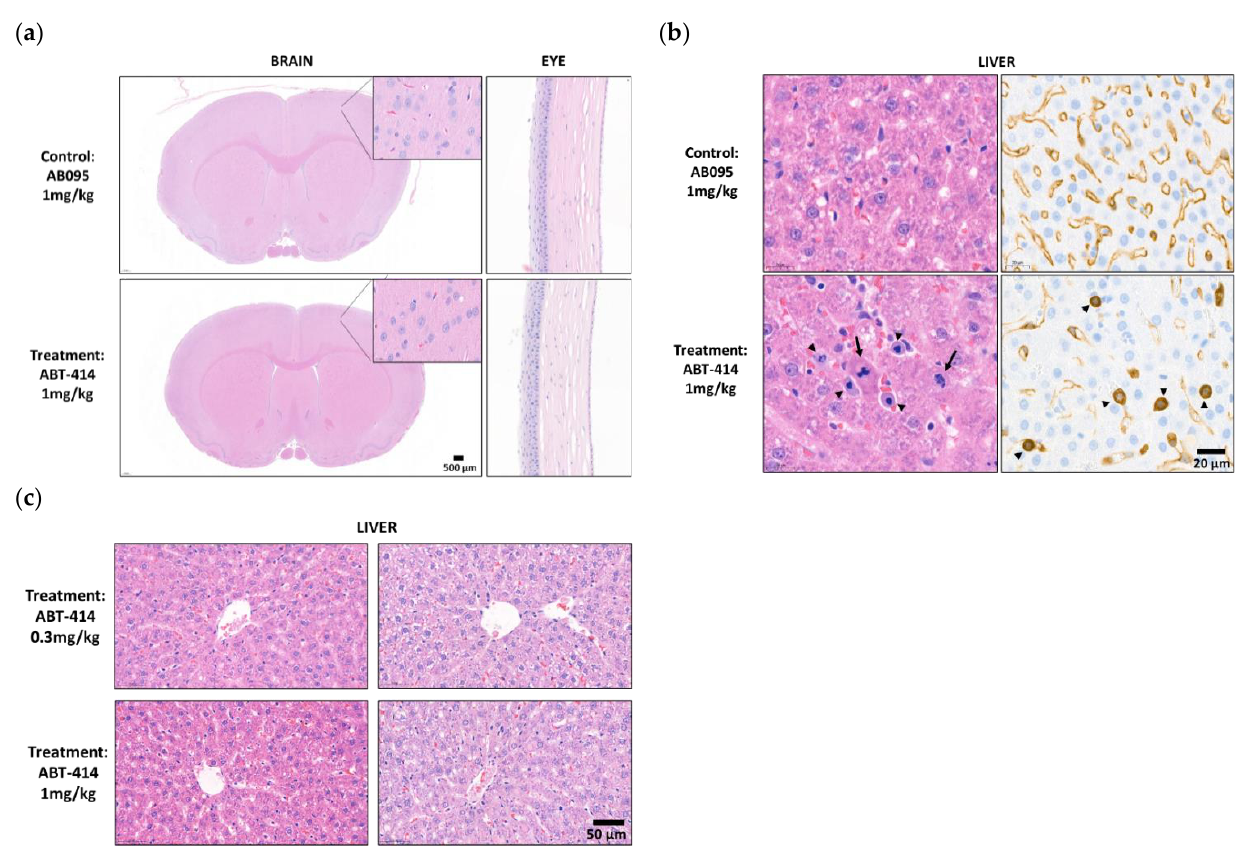
Figure 5. Toxicity Data. No toxicity was found with ICM delivery of ABT-414 in the brain. Systemic exposure was observed in the liver of one rat. Representative images of brain (left), eye (middle), and liver (right) from one control animal administered 1 mg/kg AB095 (upper panel) and one treatment animal administered 1 mg/kg ABT-414 (lower panel). ( a ) There was no toxicity in the brain (inset showing healthy neurons from the cerebral cortex) and eye (cornea). ( b ) In the liver of one animal administered 1 mg/kg ABT-414, there were increased number of mitotic figures and single cell necrosis within hepatocytes (arrows) and mitotically arrested sinusoidal cells (arrow heads) in the animal administered ABT-414 (H&E). Sinusoidal cells showed strong reactivity to Vascular Endothelial Growth Factor Receptor 2 (VEGFR2) immunostaining (arrow heads, lower right corner). In contrast, VEGFR2 staining of control rat liver tissue showed diffuse and continuous positive signal in sinusoidal endothelial cells (SECs) lining the hepatic cords (upper right corner) (IHC). ( c ) There were no microscopic liver changes associated with ICM delivery of a lower dose of ABT-414 at 0.3 mg/kg. The other two rats administered ABT-414 at 1 mg/kg did not show any microscopic findings in the liver (H&E). n = 3 animals per treatment group.